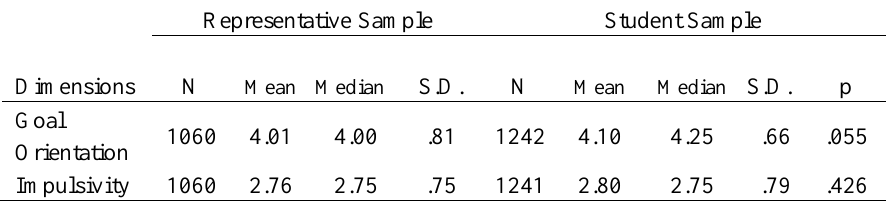
Descriptive data on ScSRQ-CZ of the representative and the student samples Representative